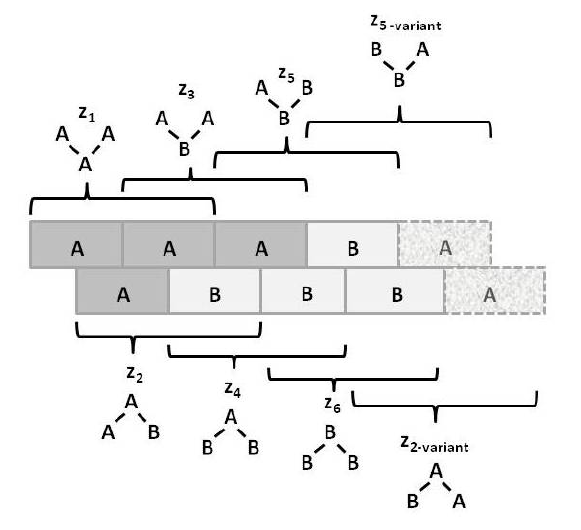
Figure 3. The six ways in which the configurations z i can be constructed.